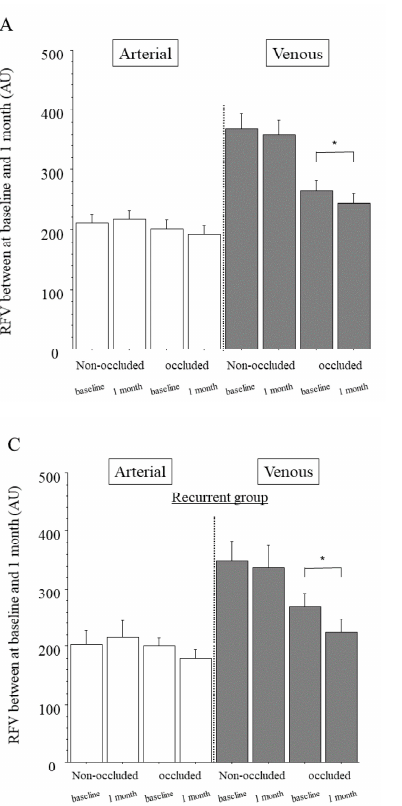
Figure 2 Figure 2. Relative blood volume between baseline and 1 month after intravitreal ranibizumab injection. ( A ) In the whole sample, we found no significant differences of relative flow volume (RFV) between baseline and 1 month after intravitreal ranibizumab injection (IRI) in the arteries of the non-occluded ( p = 0.593) or occluded regions ( p = 0.245). The veins of the non-occluded region showed significant differences in RFV between baseline and 1 month after IRI ( p = 0.501), but the veins of the occluded region did not (* p = 0.029). ( B ) In the group with no recurrence of macula edema (nonrecurrent group, n = 24), we found no significant differences of RFV between baseline and 1 month after IRI in the arteries and veins of the non-occluded and occluded regions (arteries: p = 0.918, p = 0.904, respectively; veins: p = 0.641, p = 0.859, respectively). ( C ) In the group with recurrence of macular edema (recurrent group, n = 23), we found no significant differences in RFV between baseline and 1 month after IRI in the arteries of the non-occluded and occluded regions ( p = 0.540, p = 0.090, respectively) or veins of the non-occluded region ( p = 0.638); however, we did find a significant difference in RFV between baseline and 1 month after IRI in the veins of the occluded region (* p